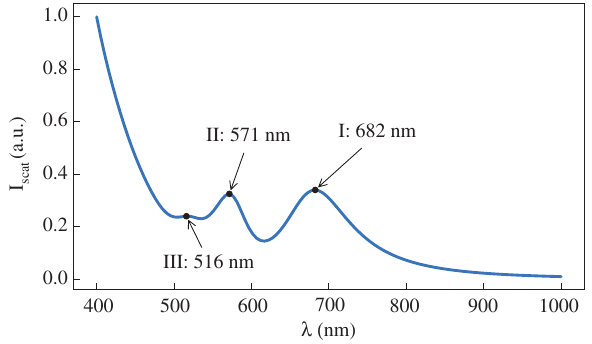
Figure 4: Simulated scattered intensity of a spherical gold dimer with a gap width of 2 nm on a silicon substrate with 1 nm of silicon oxide. Both spheres have a diameter of 90 nm.